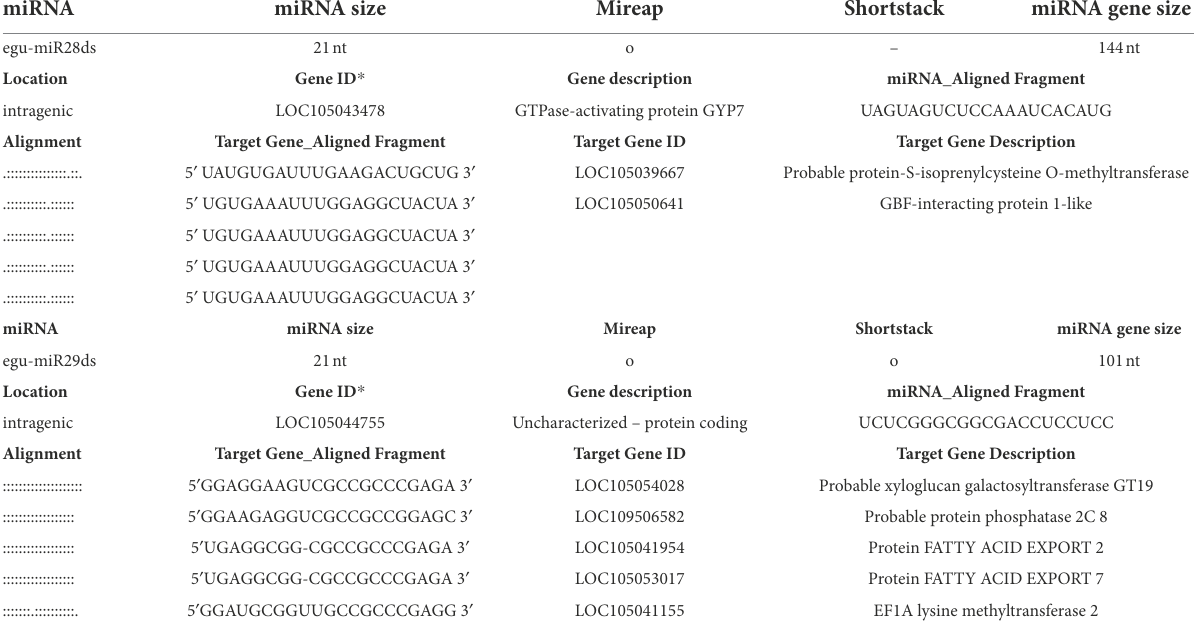
TABLE 2 The two new oil palm-specific miRNAs predicted in this study, and their putative target genes predicted using psRNA-Target online program, version 2. miRNA miRNA